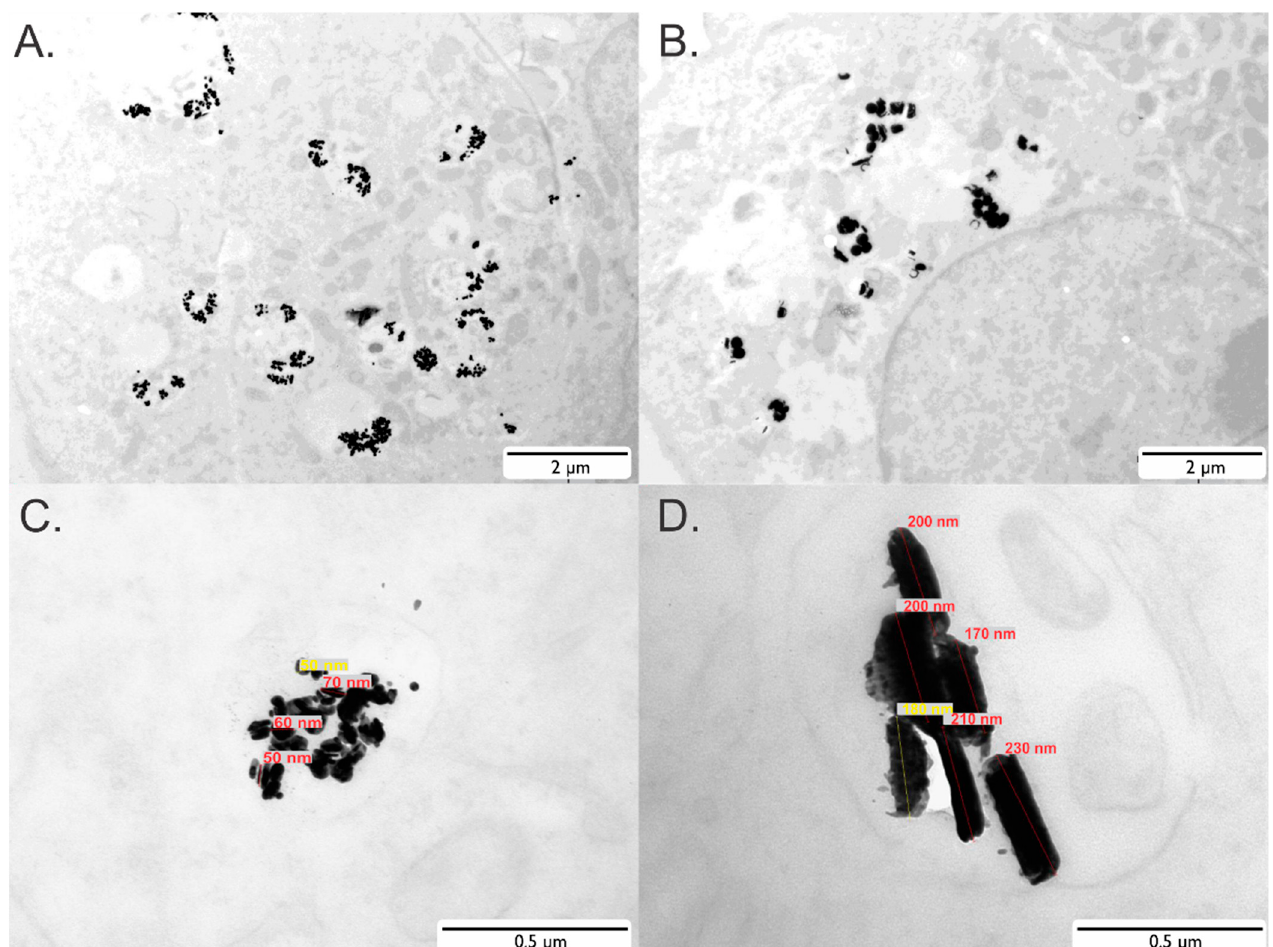
Figure 1. In vitro cell uptake of SAF-NPs. ( A , B ) TEM images of a single SAF-NP-labeled cell after overnight incubation with 90 nm ( A ) and 222 nm ( B ) SAF-NPs, revealing particle entrapment in small vesicles inside the cell. ( C , D ) Zoomed-in view of the SAF-NPs in labeled cells, indicating the size and disc-shape of the nanoparticles.